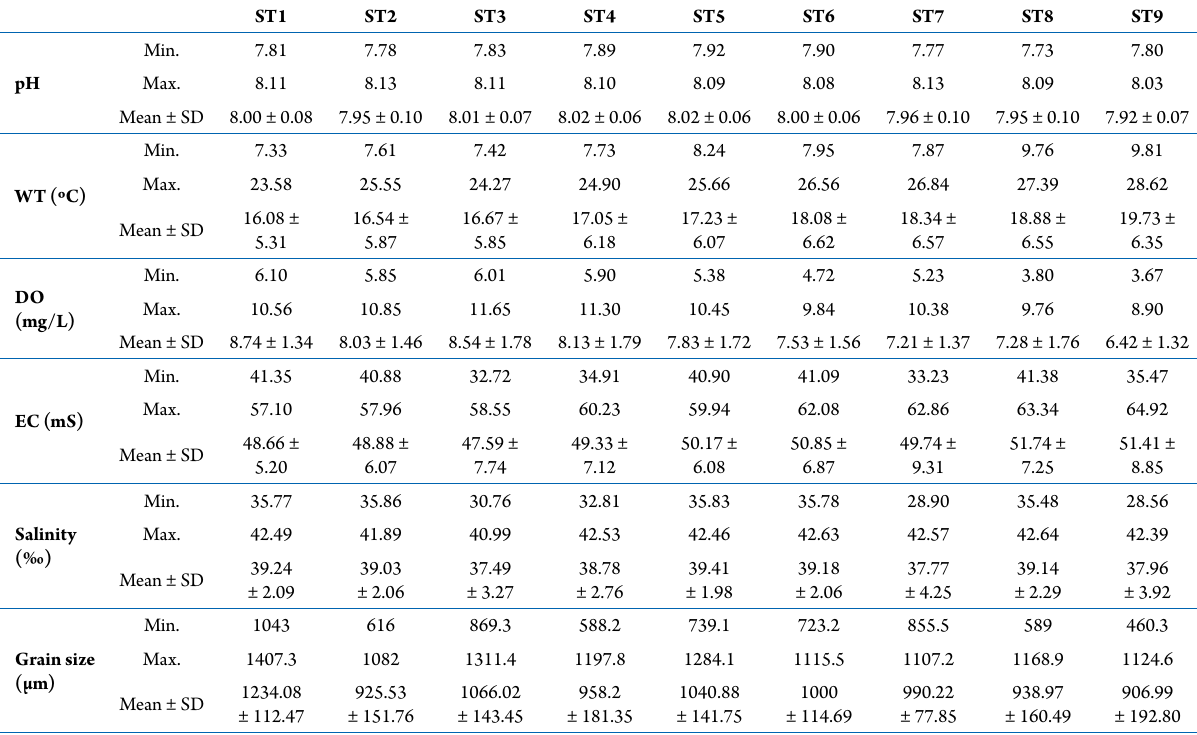
Table 2. Measured environmental parameters at the stations (SD: standard deviation). ST1